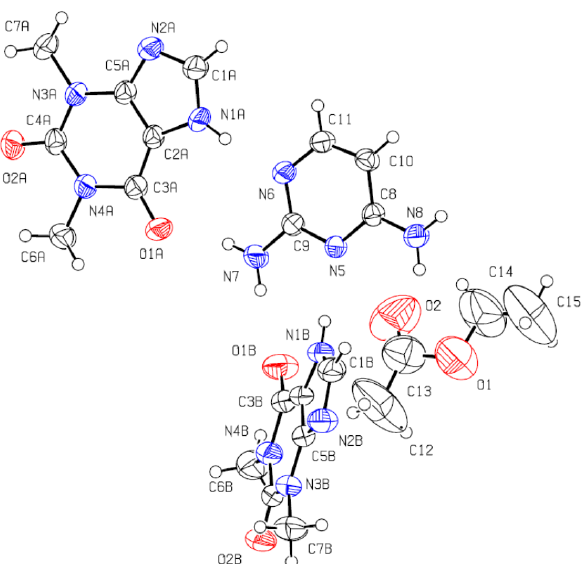
Figure 13. ORTEP diagram of the (1:2:1) 2,4-diaminopyrimidine:theophylline:ethyl acetate, CCDC 2108308. Ellipsoids are drawn at the 50% probability level. Hydrogen atoms are drawn as spheres of arbitrary radius.